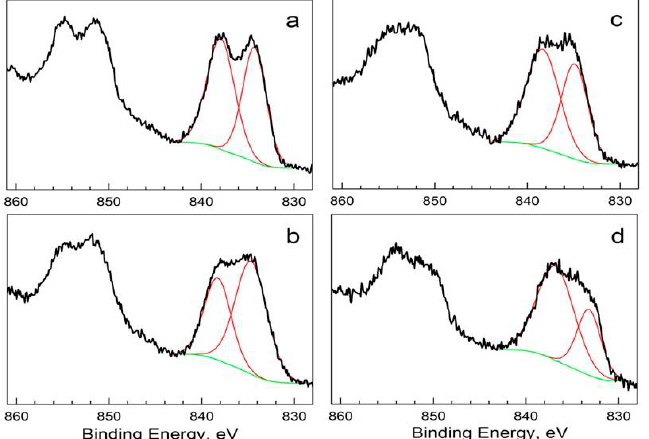
Figure 9. XPS spectra in the La 3d regions for fresh Pd-LMO/Imp ( a ) and Pd-LMO/U-AACVD ( b ), as well as for catalytic tested Pd-LMO/Imp ( c ) and Pd-LMO/U-AACVD ( d ). The multiplet splitting for La 3d5/2 is indicated by red lines.